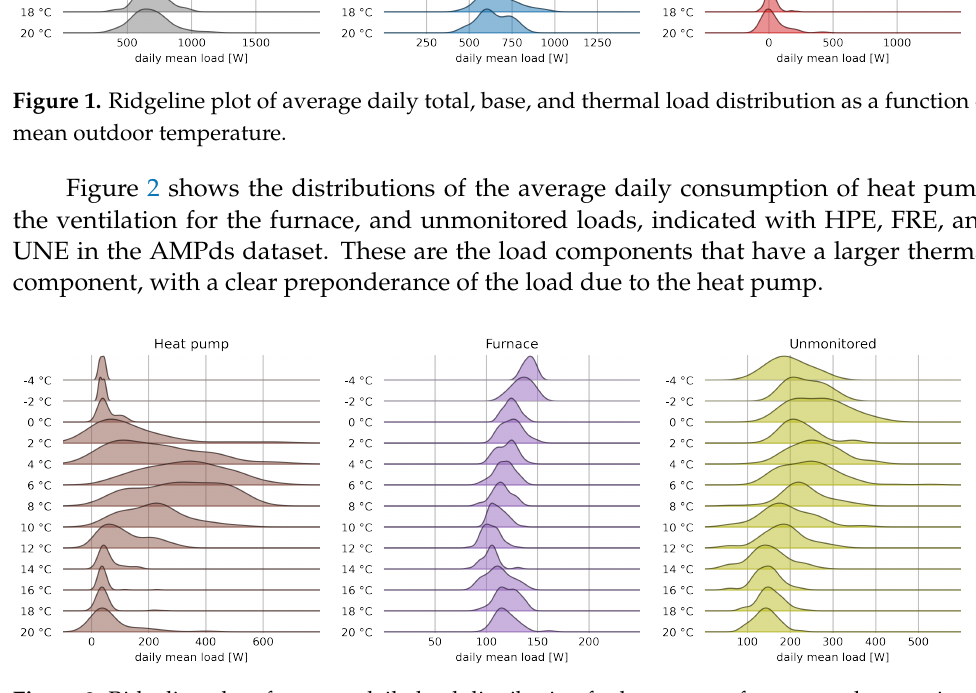
Figure 2. Ridgeline plot of average daily load distribution for heat pump, furnace, and unmonitored loads as a function of mean outdoor